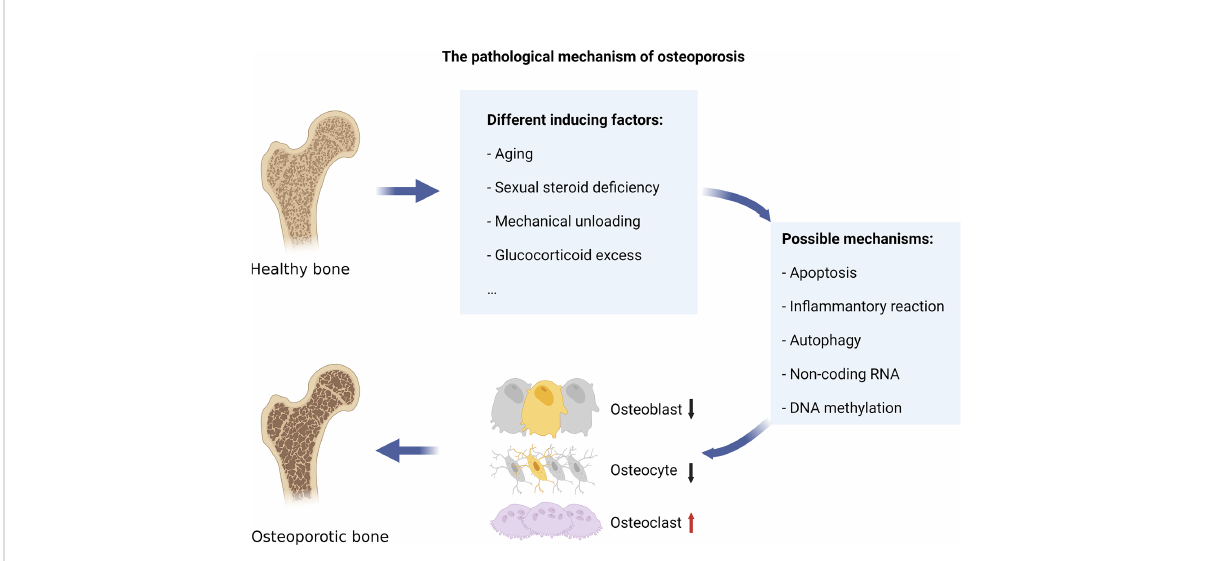
FIGURE 1 The pathological mechanism of osteoporosis. Various internal and external factors, such as aging, sexual steroid de fi ciency, mechanical unloading, and overuse of glucocorticoids, can cause bone resorption to exceed bone formation, leading to osteoporosis. The pathological mechanisms of OP mainly include the abnormal activation of osteoclasts resulting from changes in apoptosis, in fl ammatory reaction, and autophagy. Besides, epigenetic changes, such as changes in non-coding RNA and DNA methylation, can also reduce the expression of osteogenic